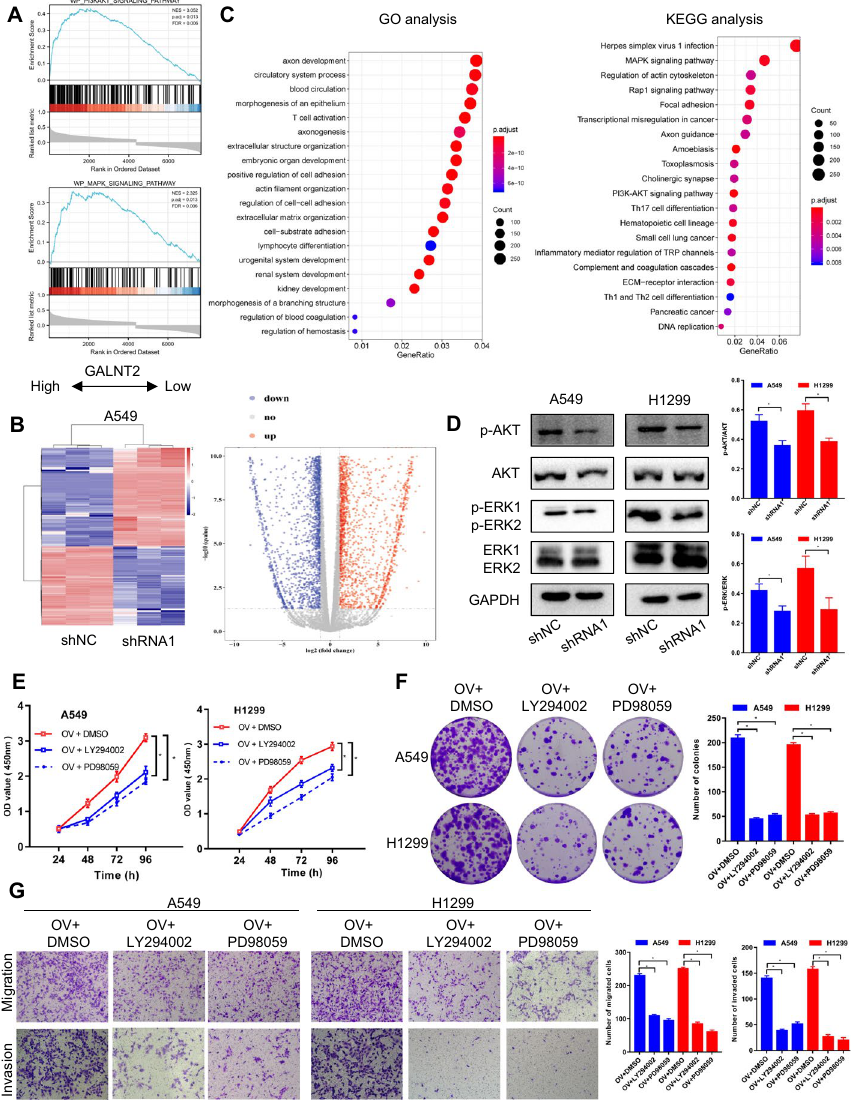
Fig. 8 The PI3K/Akt and MAPK/ERK pathways can be regulated by GALNT2 in NSCLC. A Enrichment plots from GSEA. B Heatmap and volcano plot of DEGs. C GO annotation and KEGG analysis of DEGs. D Effects of GALNT2 knockdown on the expression of PI3K/AKT and MAPK/ERK pathways. E CCK-8 assay. F Colony formation assay. G Transwell migration and Matrigel invasion assays (magnification, overexpression lentivirus, shRNA GALNT2 shRNA lentivirus, shNC negative control shRNA lentivirus. * P <